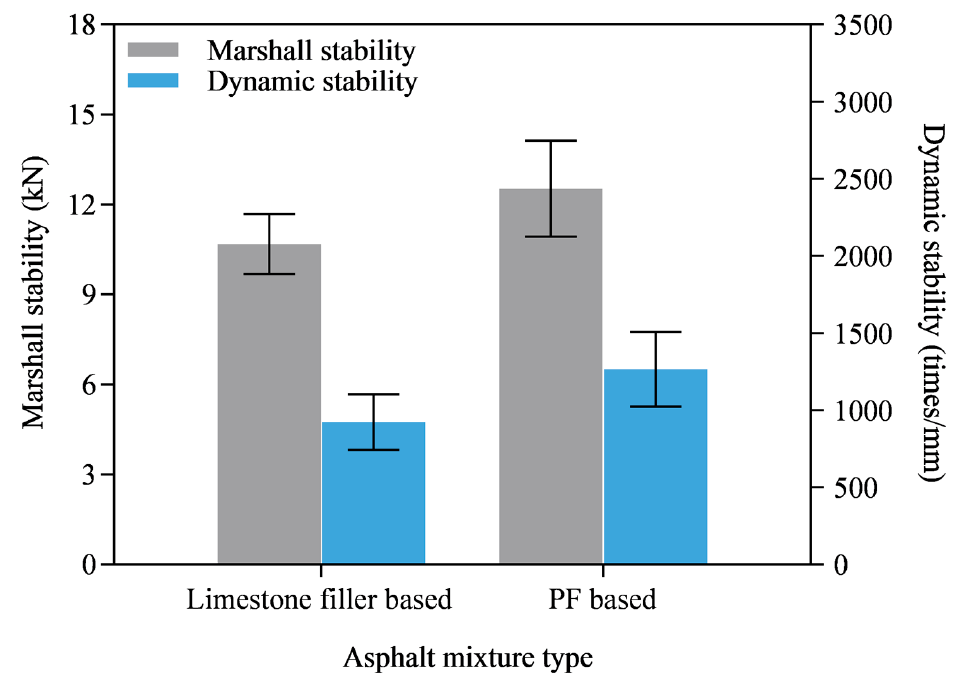
Figure 15. Marshall stability and dynamic stability of asphalt mixture.